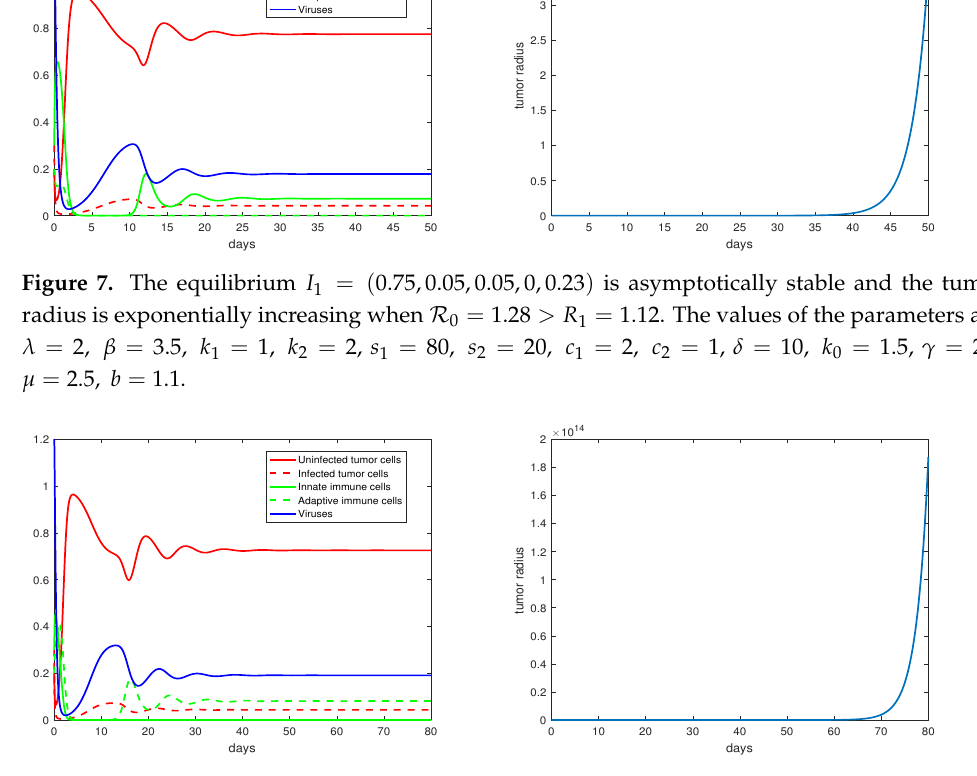
Figure 8. The equilibrium I 2 = ( 0.73,0.04,0,0.08,0.19 ) is asymptotically stable and the tumor radius is exponentially increasing when R 0 = 1.28 > R 2 = 1.14. The values of the parameters are: λ = 2, β = 3.5, k 1 = 1, k 2 = 2, s 1 = 60, s 2 = 50, c 1 = 2, c 2 = 1, δ = 10, k 0 = 1.5, γ = 2.5, µ = 2.5, b =